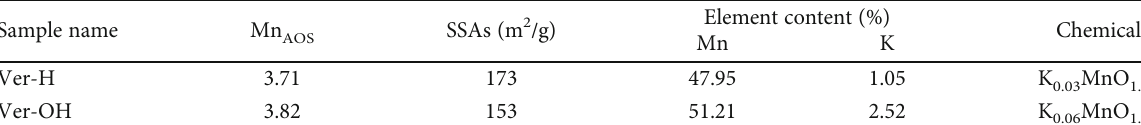
Table 1: Mn , SSAs, and chemical composition of vernadite samples. AOS